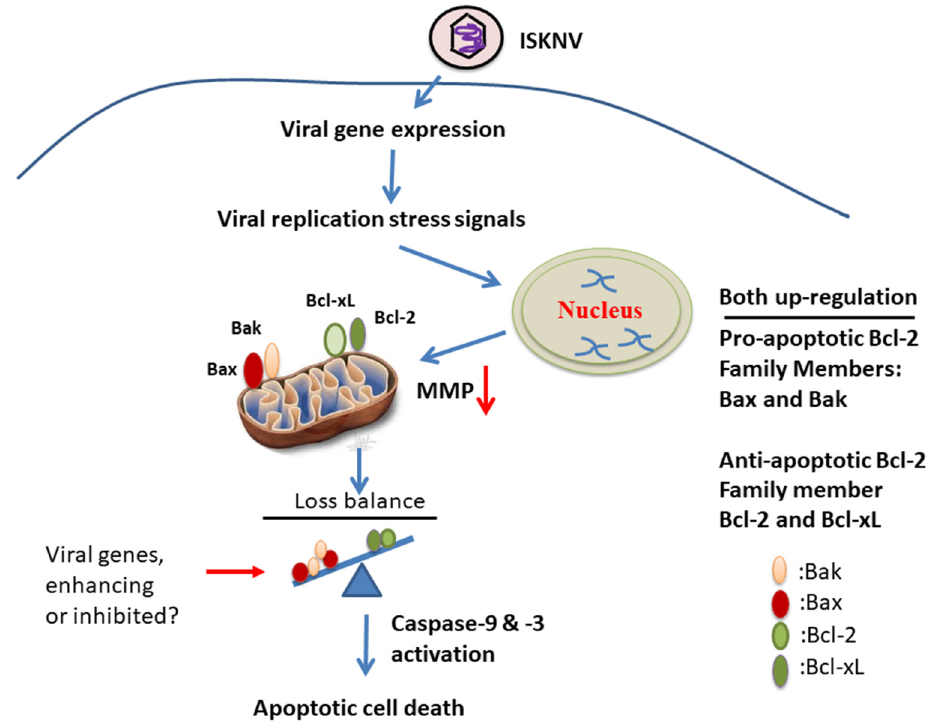
Figure 7. The hypothesis that ISKNV upregulates and induces positive and negative apoptotic cell death cascades on mitochondria function controlling in fish cells. The DNA virus ISKNV shows novel approach using stress signals that can upregulate either anti-apoptotic cell death genes Bcl-2 and Bcl- xL or pro-apoptotic cell death genes Bax and Bak during the viral replication cycle in GF-1 fish cells. This ISKNV-triggered negative and positive cell death signals are also correlated with downstream mitochondrial disruption to MMP loss and caspases-9/-3 activation in GF-1 cells. Interestingly, ISKNV-induced Bax/Bak-mediated cell death signaling might be inhibited or enhanced by viral genes from the viral genome such as GIV66 (apoptosis inhibitor; [55]) and GSIV serine/threonine kinase (apoptosis inducer; [56]) during viral replication.